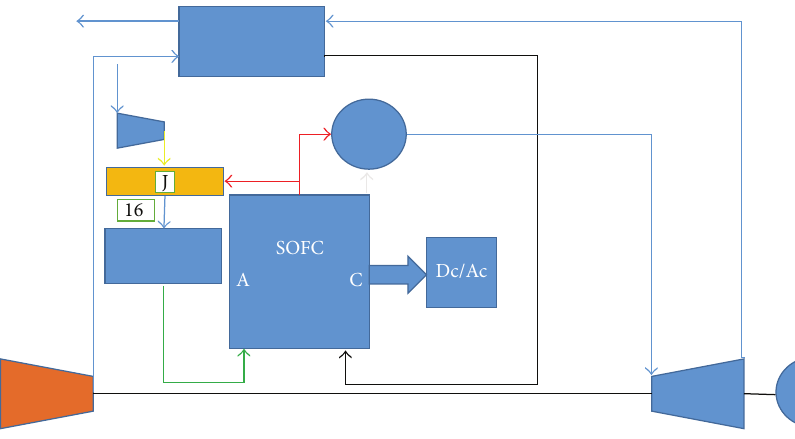
Figure 11: Hybrid system studied in